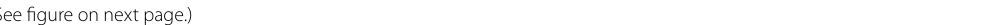
figure on next Fig. 3 Typical lithologies from the SW part of the Aiguilles‑Rouges massif. A Typical migmatitic paragneiss of the basement featuring vertical S 2 foliations from the eastern of the Servoz syncline, near the Lac Cornu (45.963029; 6.855187). B Anatectic metavolcano‑sedimentary rocks of the Pormenaz unit (AR982) from the western side of the Servoz syncline featuring shallowing dipping S 1 foliations (45.865415; 6.734047). C Fine‑grained gneiss from the Pormenaz unit in the Prarion area with S 3 foliations folding S 2 foliations (45.894366; 6.750432). D Micaschists from the Pormenaz unit featuring S 2 foliations with relict S 1 foliations, eastern side of the Servoz syncline near the Pormenaz granite (45.941785; 6.812287). E Metavolcanic rock from the Forclaz unit with vertical S 2 foliations and F3 open folds, Prarion area, western side of the Servoz syncline (45.906418; 6.753869). F Acid (45.867327; 6.744562) and G mafic rocks (45.866916; 6.745102) from the bimodal magmatic suite from the Prarion area. H Intrusion of the Montées‑Pélissier granite in Visean metagreywackes from the eastern side of the Servoz syncline (45.898301; 6.772357). I Visean phyllites and local metagreywacke layer featuring pervasive S 3 foliations from the western side of the Servoz syncline, Prarion area (45.923449; 6.756683). J Kasimovian‑Asselian conglomerate with mylonitic gneiss boulder, Pormenaz area (45.962838;